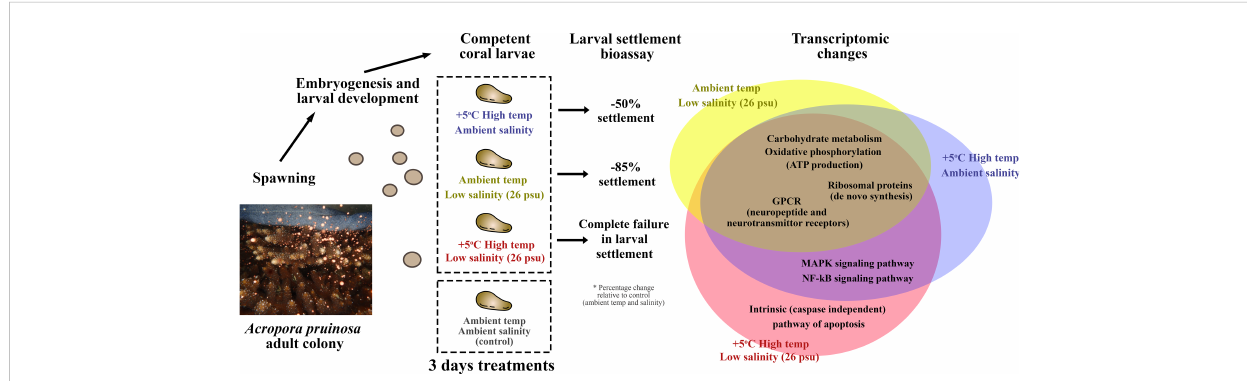
FIGURE 7 Summary of the major fi ndings. HT, LS and HTLS treatments led to 39%, 12% and 0% settlement of A. pruinosa competent larvae, or 50, 85 and 100% reduction in settlement success respectively, compared to 78% settlement rate of coral larvae in the control group. The Venn diagram on the right- hand side summarizes the similarity and differences in DEGs expression in coral larvae under low salinity or high temperature single stressor treatments, and low salinity + high temperature double stressor